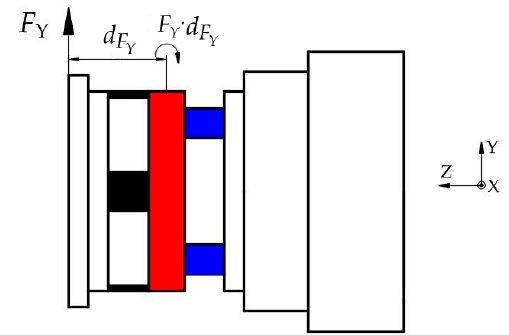
Figure 16. The moment applied on layer B caused by F Y .